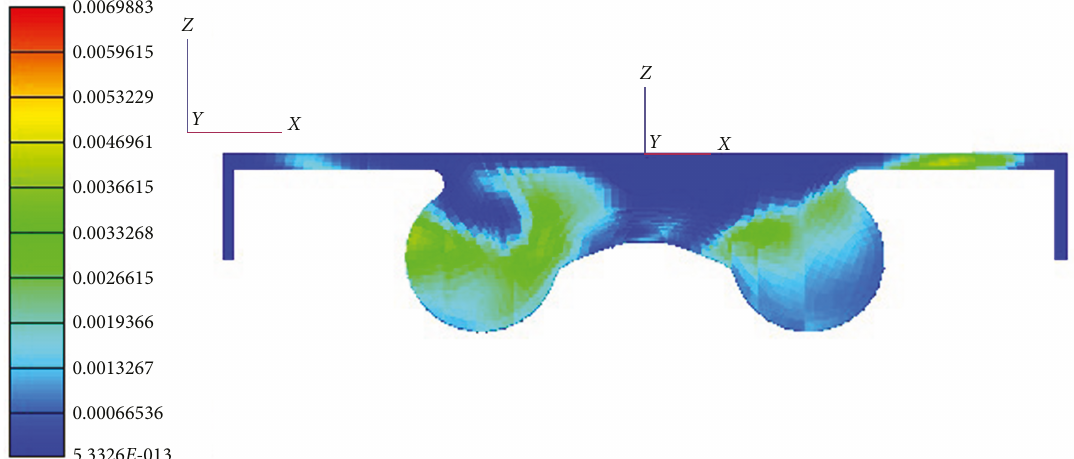
Figure 7: The distribution of NO